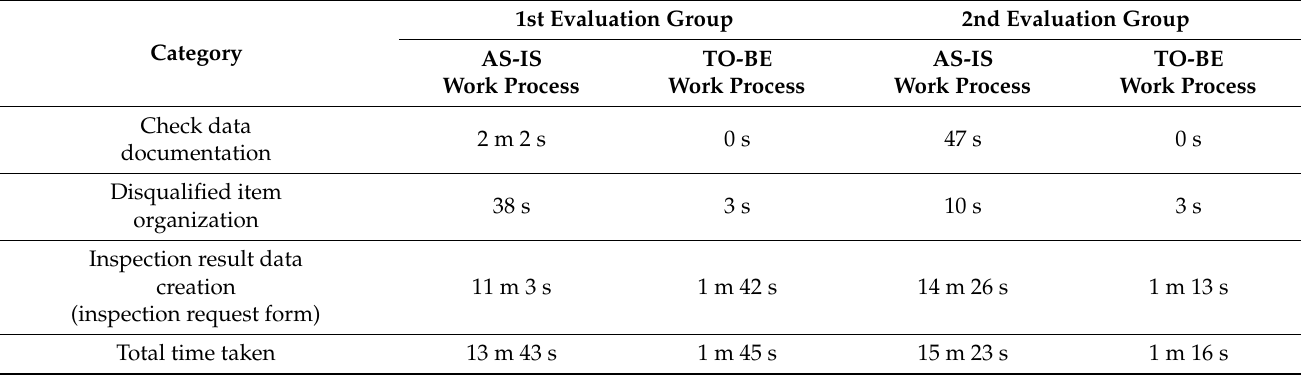
Table 9. Result of the amount of time taken for each work process in the post-inspection work.